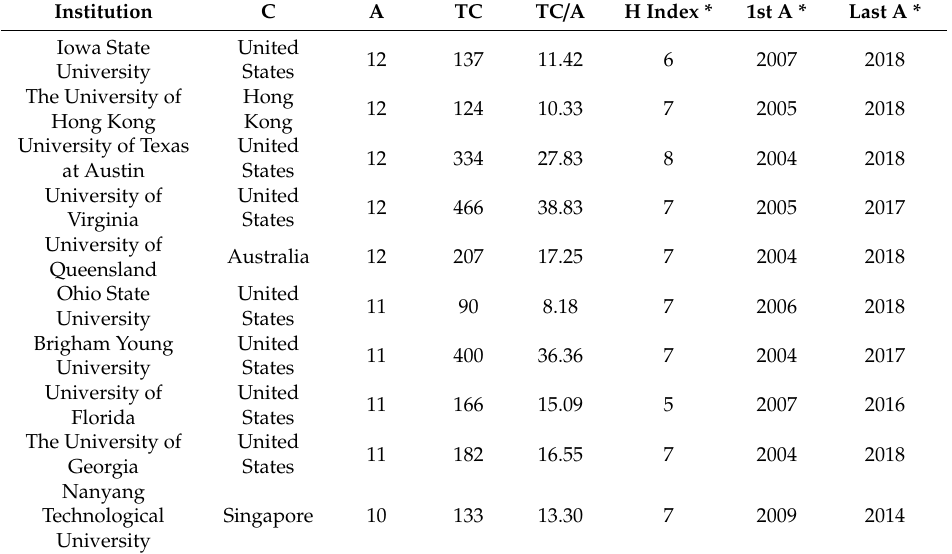
Table 6. Most productive institutions in number of articles on the impact of the university classroom on managing the socio-educational well-being (2004–2018).